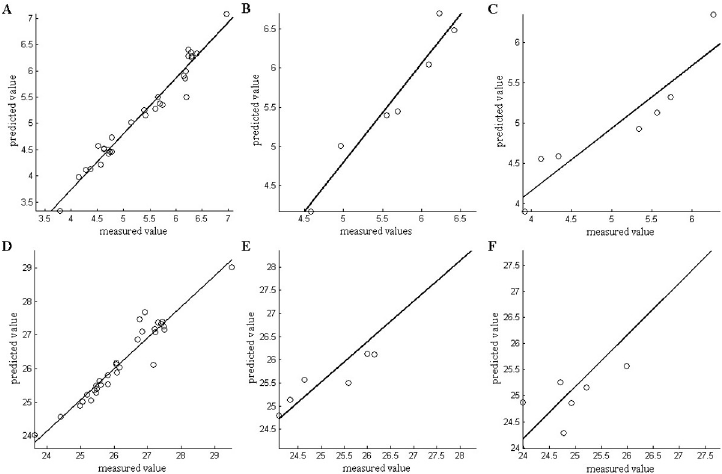
Fig 4. Establish the BPNN model for the bitter and astringent taste of tea. a. Calibration set for the bitter taste of tea b. Validation set for the bitter taste of tea c. Prediction set for the bitter taste of tea d. Calibration set for the astringent taste of tea e. Validation set for the bitter taste of tea f. Prediction set for the astringent taste of